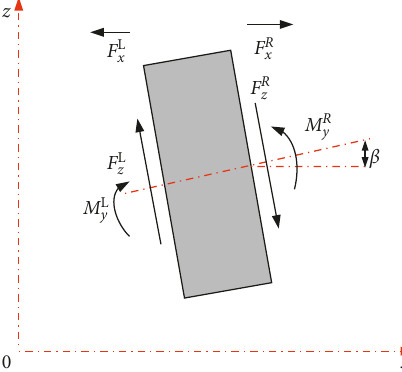
Figure 4: Schematic diagram of the positive direction of the end-state vector of the mass